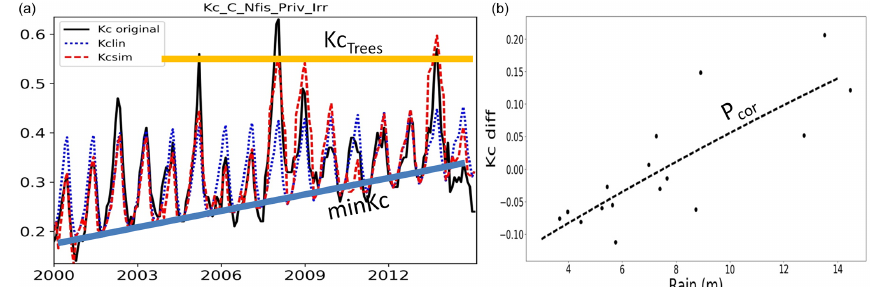
Figure 3. (a) Quantities used to perform the simulation. The example illustration on the left depicts the synthetic K c of the N’Fis private area where a mix of tree crops (olive, orange, apricot) and cereal crops (mainly wheat) are cultivated. The peak occurs during March and April when cereal crops are at their maximum development; the valleys correspond to the summer months when there are no seasonal crops. The three curves are the K c time series obtained from remote sensing processing (solid line), the linear estimation ( K c , lin , Eq. 3, dotted blue line), and the estimation corrected with rainfall ( K c , sim , Eq. 6, dashed red line). K c , Trees has been set to 0.55 in Eq. (8), and minKc is the yearly minimum of K c on K c , sim . (b) The fitted correction curve of K c according to the cumulated rainfalls ( P corr ) is almost linear in this